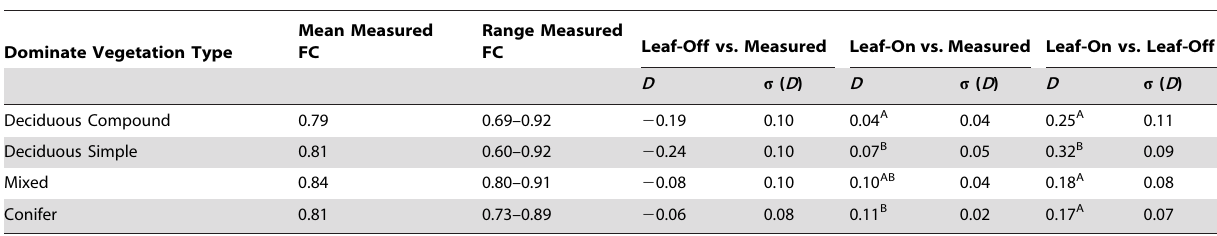
Table 6. Fractional cover results stratified by vegetation type.